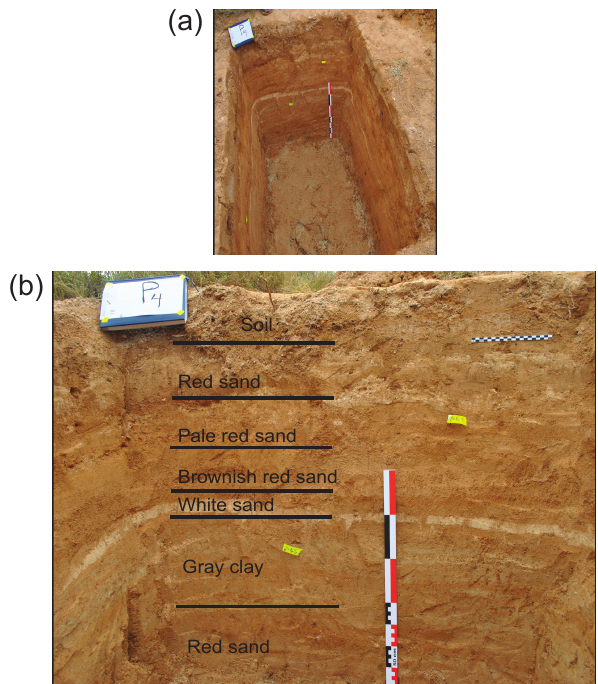
Figure 3. (a) Trench (P4) panorama at Kefr Saber, and (b) descrip- tion of sedimentary layers of trench P4 with carbon dating sampling (yellow flags). The horizontal ruler indicates 20cm